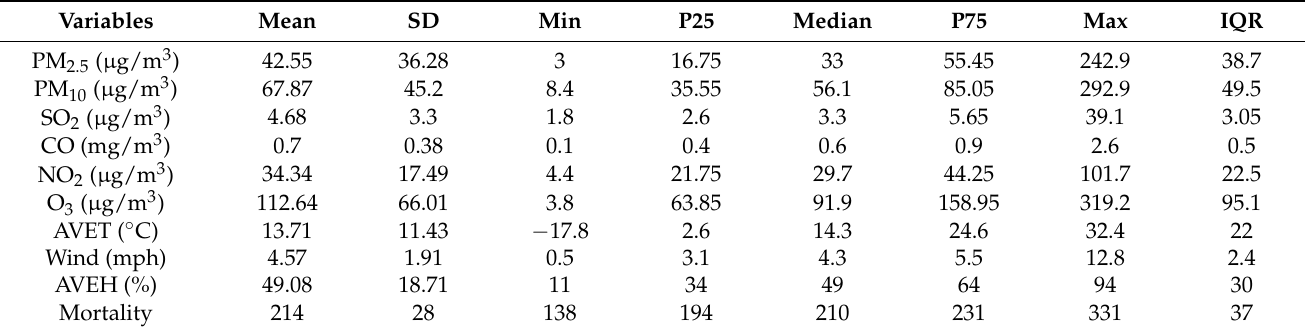
Table 1. Summary of environmental variables and daily nonaccidental deaths in Beijing from 2018 to